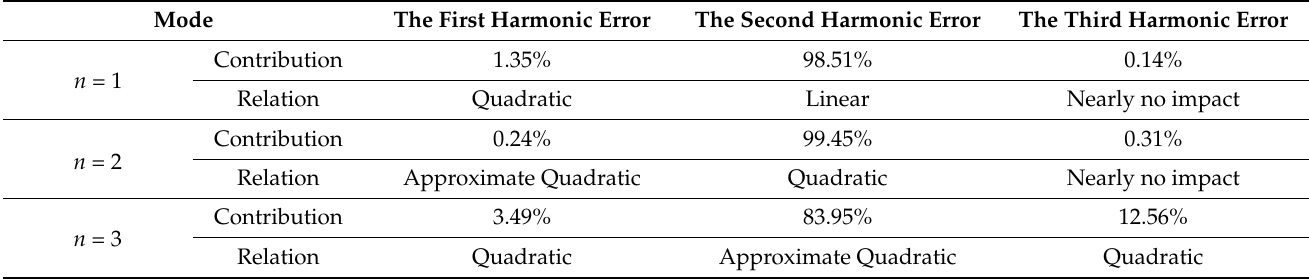
Table 2. Contribution of the first three harmonic errors on each mode when ρ i = 100 kg/m 3 and the relations between the frequency splits and the first three harmonic